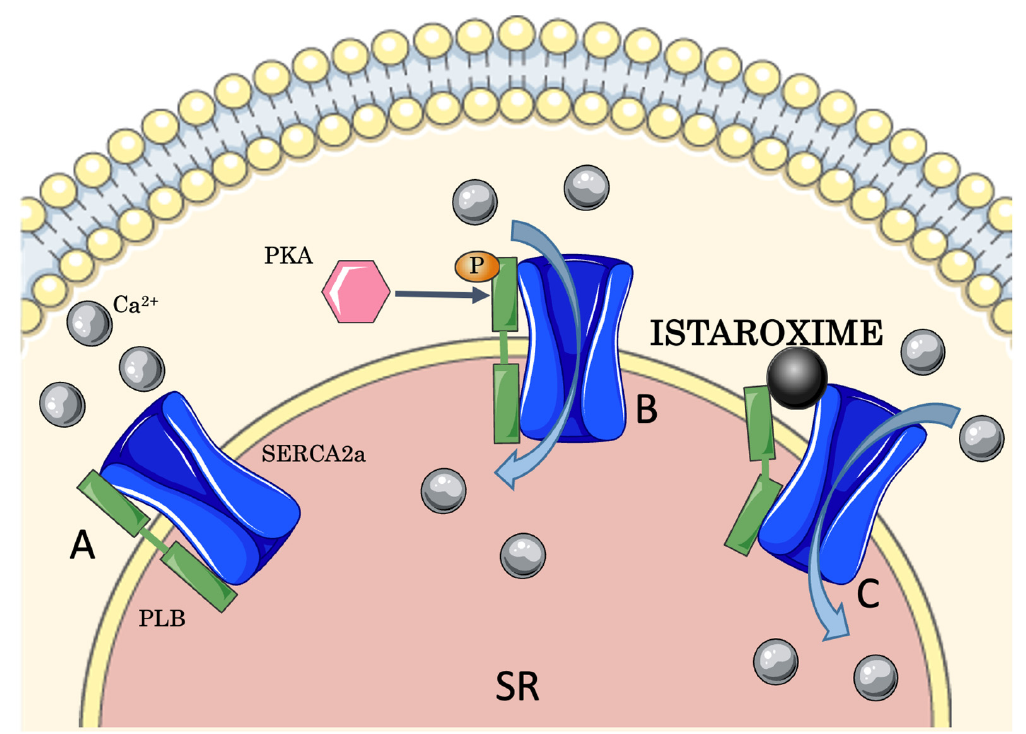
Figure 2. Istaroxime activates SERCA2a. ( A ) PLB, in its dephosphorylated form, inhibits SERCA2a. ( B ) PKA phosphorylates PLB releasing SERCA2a inhibition, thereby Ca 2+ can be re-uptaken from the cytosol to the sarcoplasmic reticulum (SR). ( C ) Istaroxime activates SERCA2a with a direct interaction with the SERCA2a/PLB complex, independent of PLB phosphorylation. PKA: protein kinase A; PLB: phospholamban; SERCA2a: sarco/endoplasmic reticulum Ca 2+ ATPase 2a.